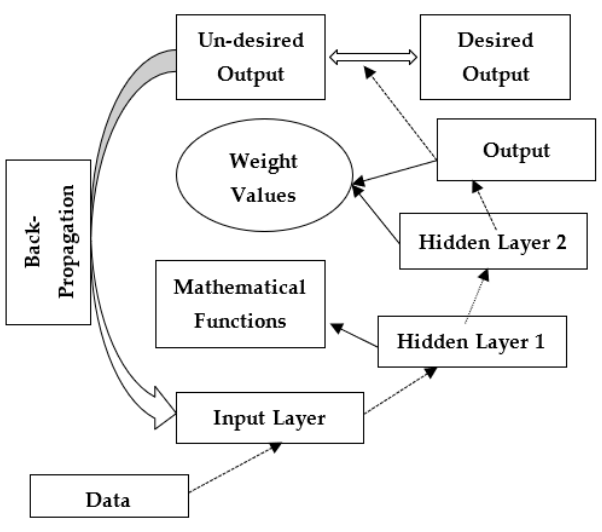
Figure 5. Flow sheet diagram of MLP.